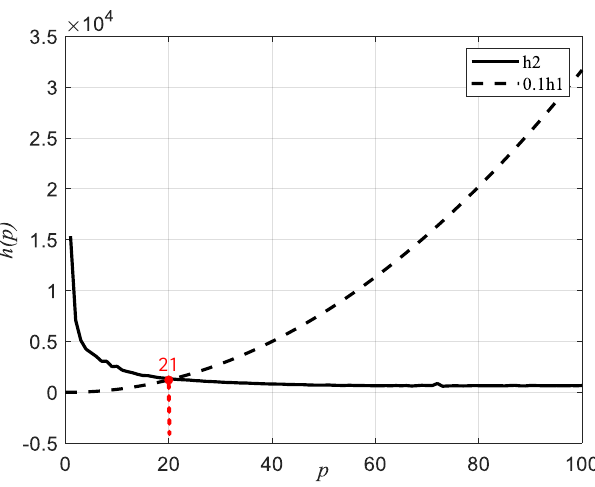
h p and h p . 1 2